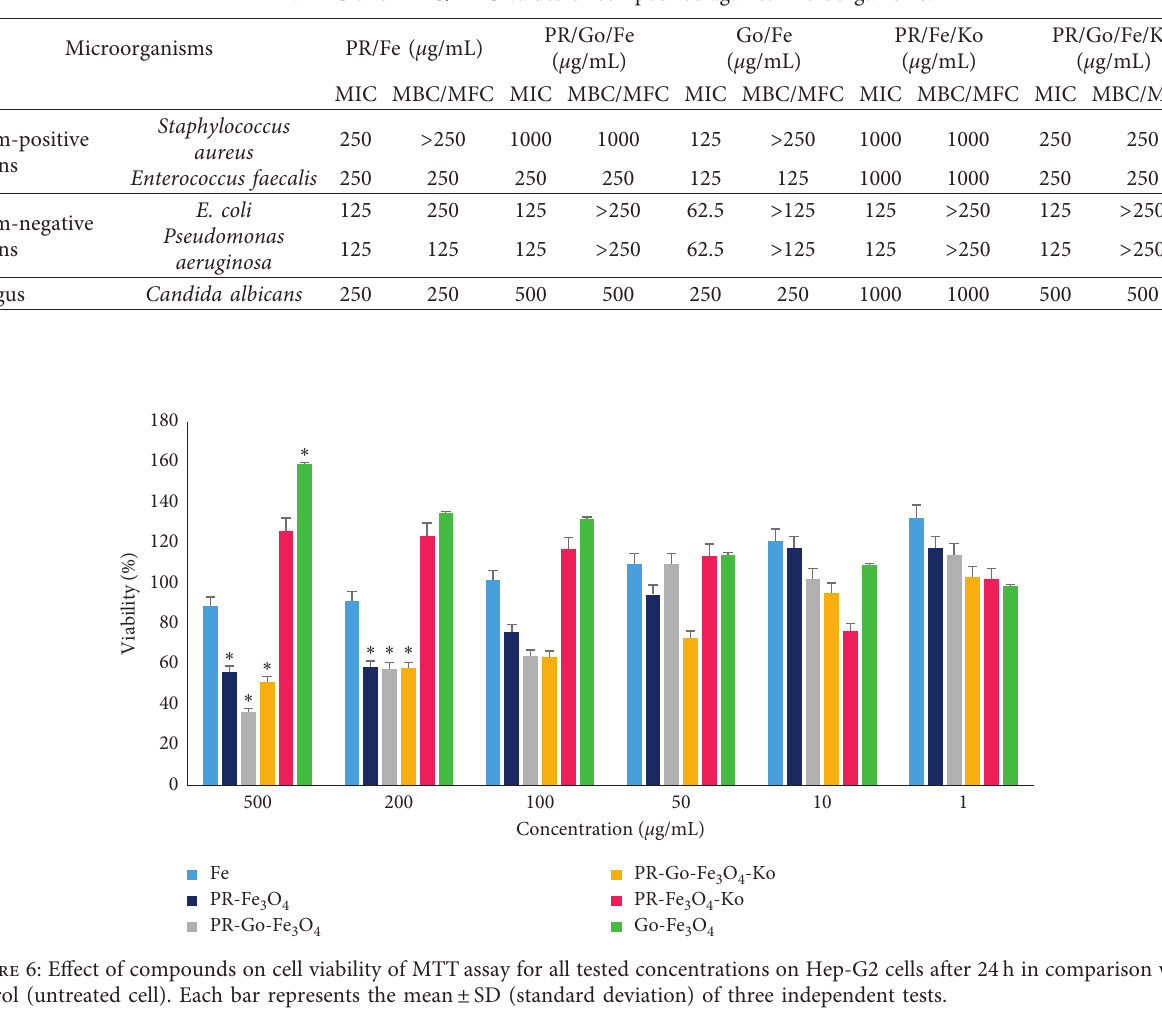
Table 1: MIC and MBC/MFC values of compounds against